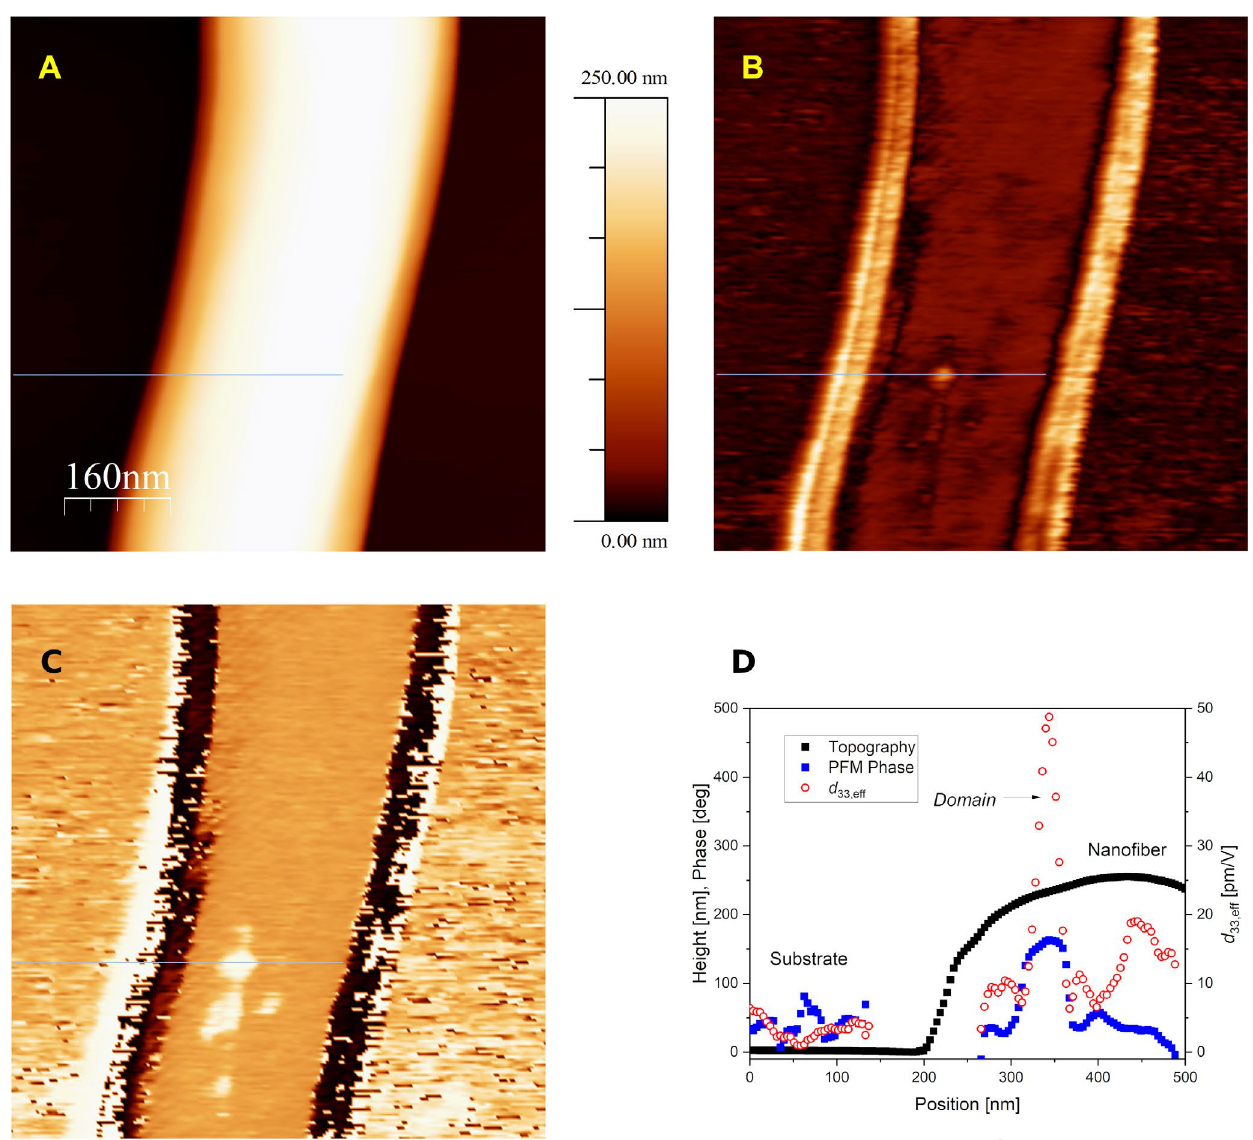
Figure 2. ( A ) Topography and CE-FM-PFM amplitude ( B ) and phase ( C ) scan of a portion of electrospun PVDF/BaTiO 3 composite nanofiber, transferred on a doped silicon substrate. Bands on the flanks of the nanofiber in ( B , C ) should be disregarded, since they are caused by a spurious tip shape effect on the sloped region. Nanodomains show up on the fiber upper surface, where PFM phase is inverted. ( D ) Line profile corresponding to the horizontal stroke in ( A – C ), whose length is 500 nm. Data corresponding to the sloped region of the nanofiber have been excluded from the plot for clarity. Image size is 785 nm × 785 nm. The same color bar used in image ( A ) also defines the values of image ( B ) (0/100 pm/V) and ( C ) (−180°/+180°) .